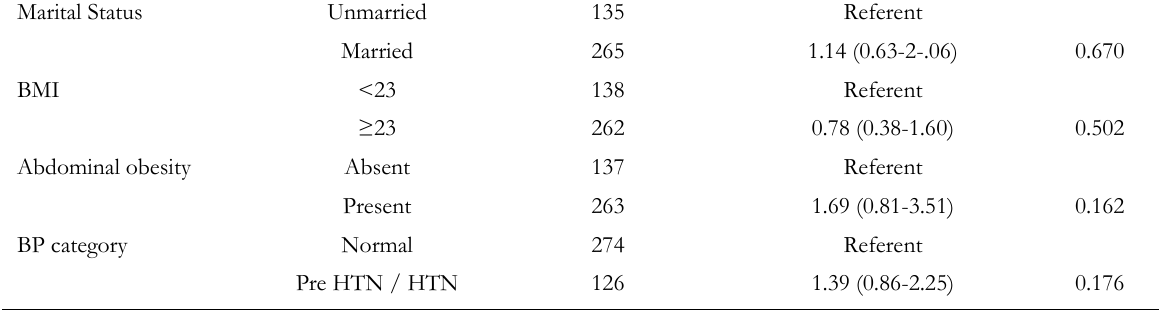
Table 3 Binary logistic regression for the predictors of major depression